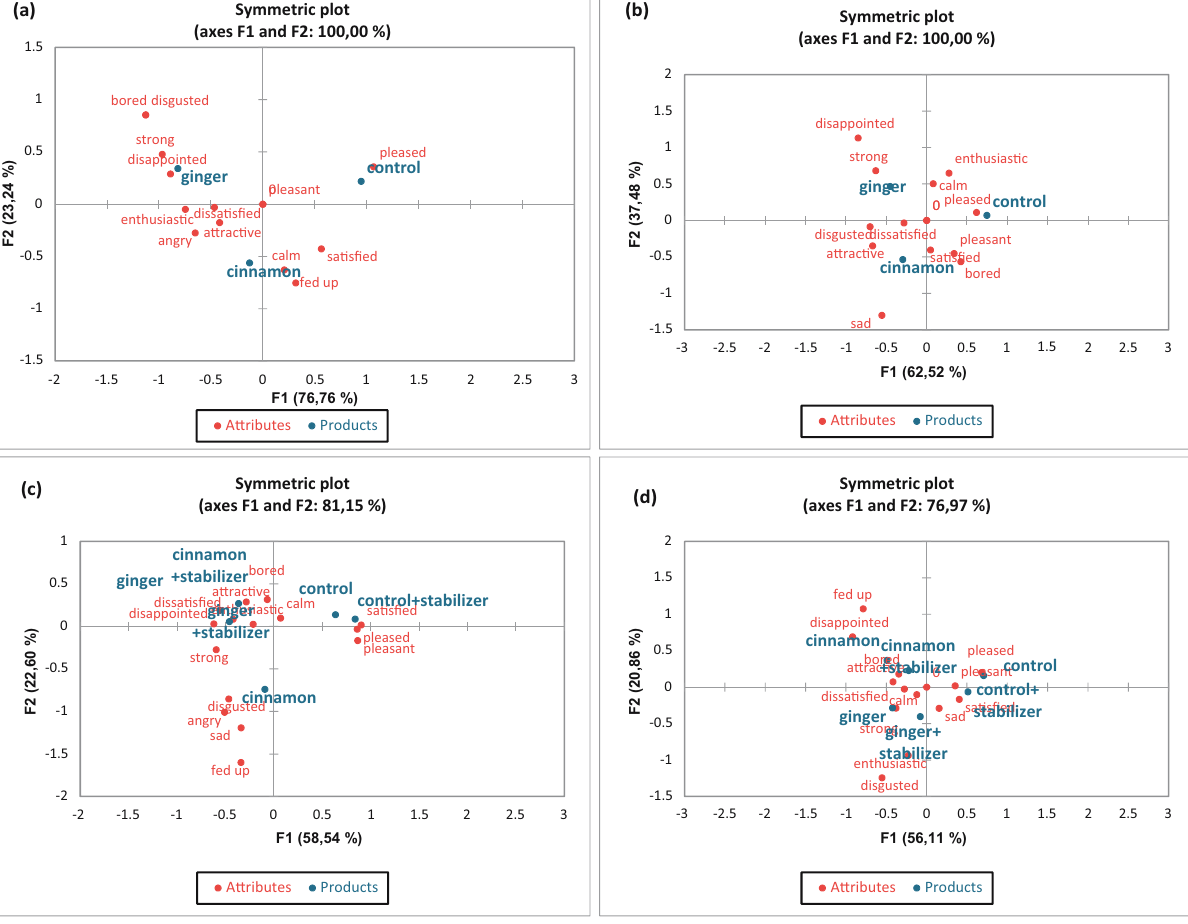
Figure 2: Emo - sensory pro fi le of chocolate bar without information intervention ( a ) and with information intervention ( b ) and cocoa drink without information intervention ( c ) and with information intervention ( d )